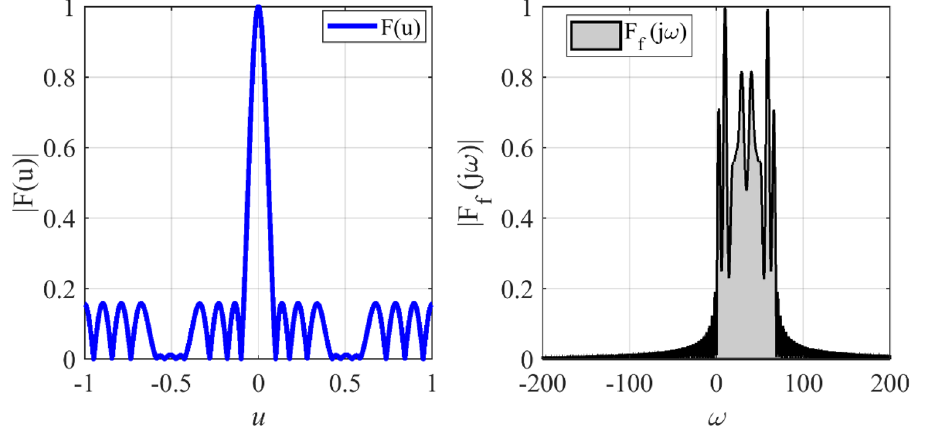
Figure 11. The desired pattern of the fourth case and its Fourier